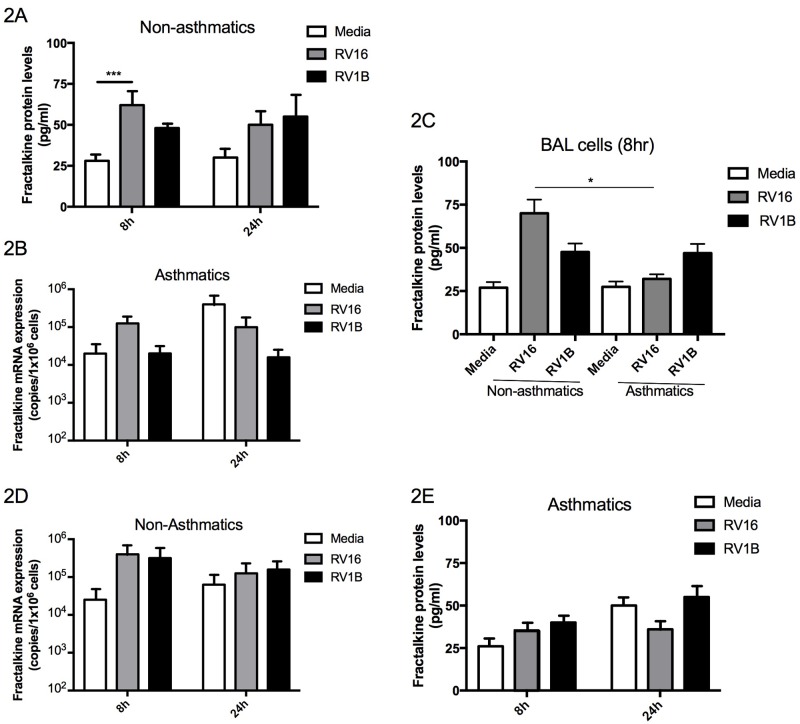
Change in levels of fractalkine in BAL cells following in vitro infection with RV16 and RV1B.Soluble fractalkine protein was measured in cell supernatants from BAL cells obtained from (A) non-asthmatic (n = 15) and (B) asthmatic (n = 15) subjects and compared between subject groups at 8hrs post infection (C). Fractalkine mRNA expression was measured in BAL cell lysate cDNA obtained from non-asthmatic (D) and asthmatic (E) subjects. The results are expressed as mean ± SEM. Protein data were analysed by one-way ANOVA with Bonferroni post-test and mRNA by Kruskal Wallis with Dunn’s post test (**P<0.01).